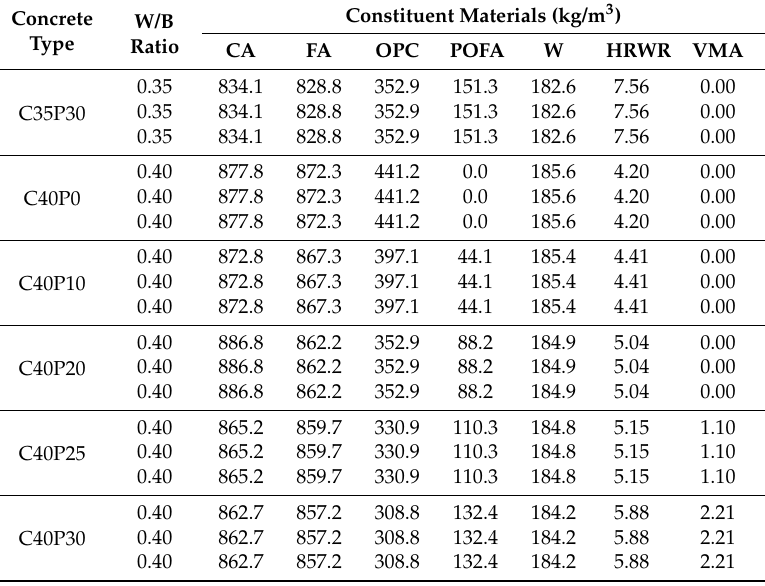
Table 6. Details of the mix proportions and compressive strength values of concretes used in the testing process of ANN model.